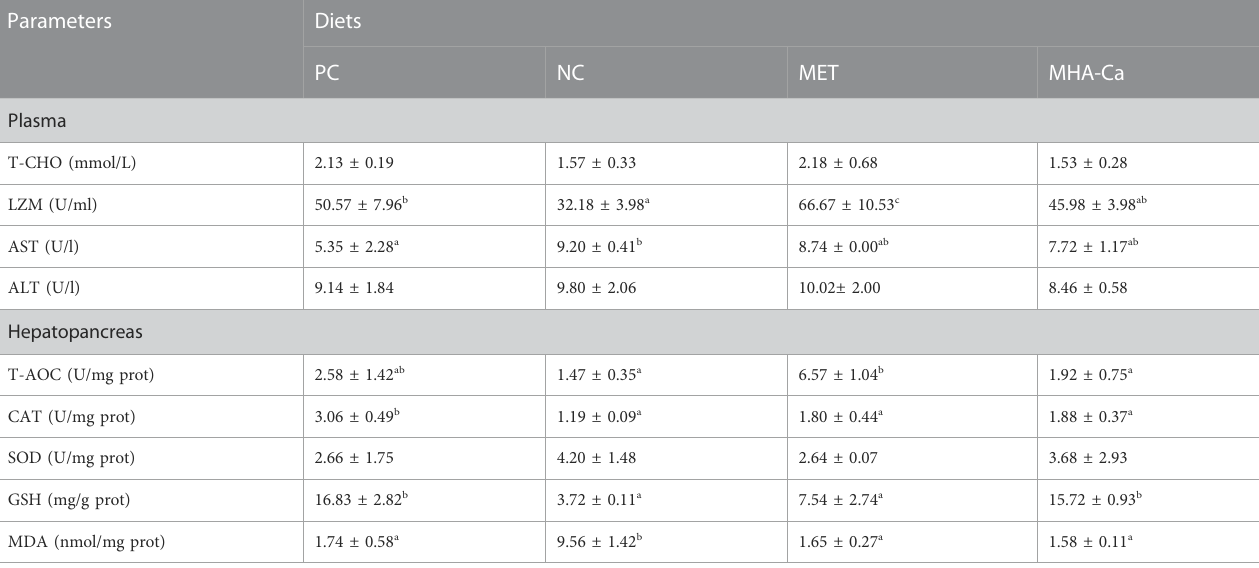
TABLE 7 Biochemical parameters of juvenile L. vannamei fed the experimental diets.